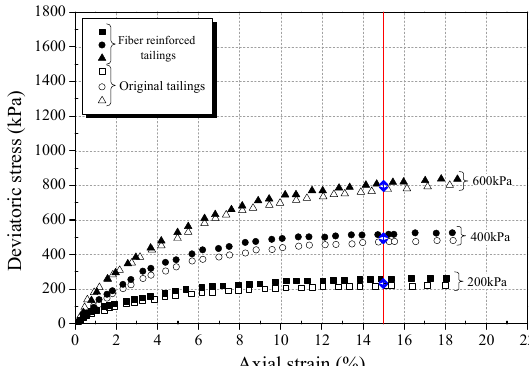
Figure 13. Stress strain curve for unreinforced and reinforced tailings clay (0.4 wt% fiber content).